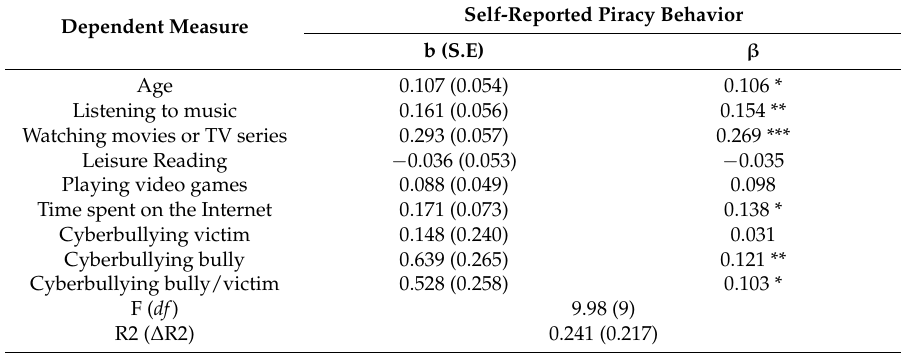
Regression analyses: associations of leisure activities, time spent on the Internet, and cyberbullying roles on self-reported piracy behavior for male participants.